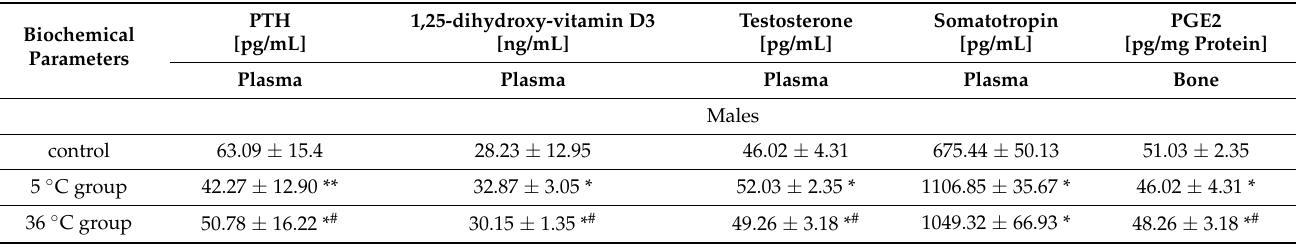
Table 3. Plasma levels of parathyroid hormone (PTH); 1,25-dihydroxy-vitamin D3; testosterone and somatotropin in plasma, and bone levels of prostaglandin E2 (PGE2) in male rats from the control and test groups. Biochemical